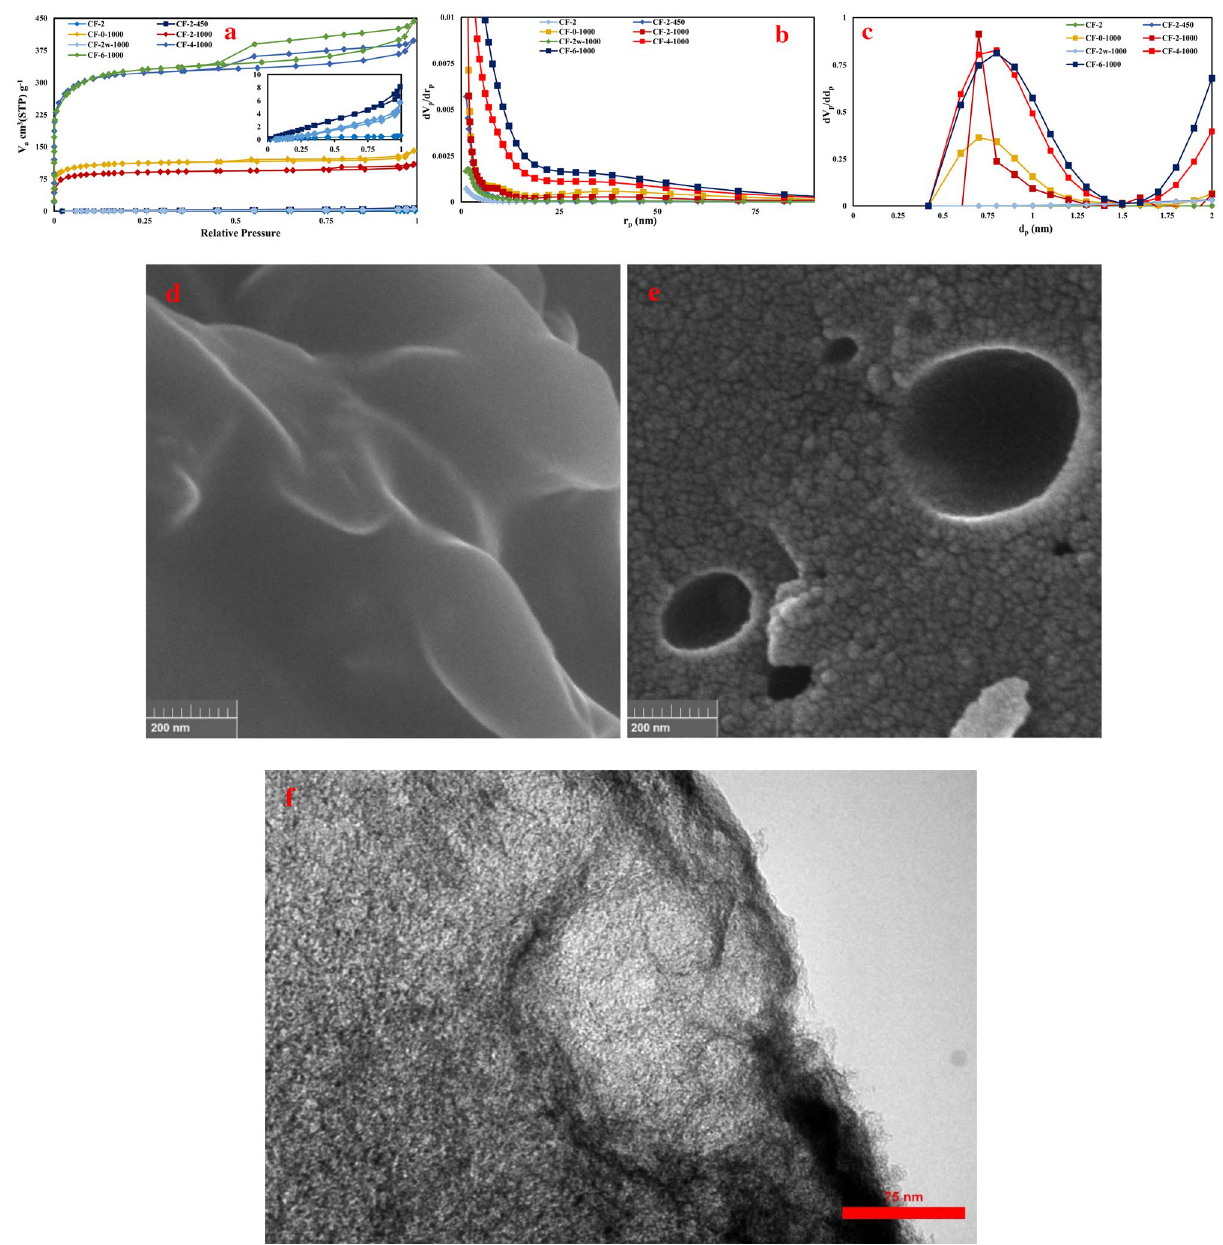
Transmission electron microscopy micrograph of